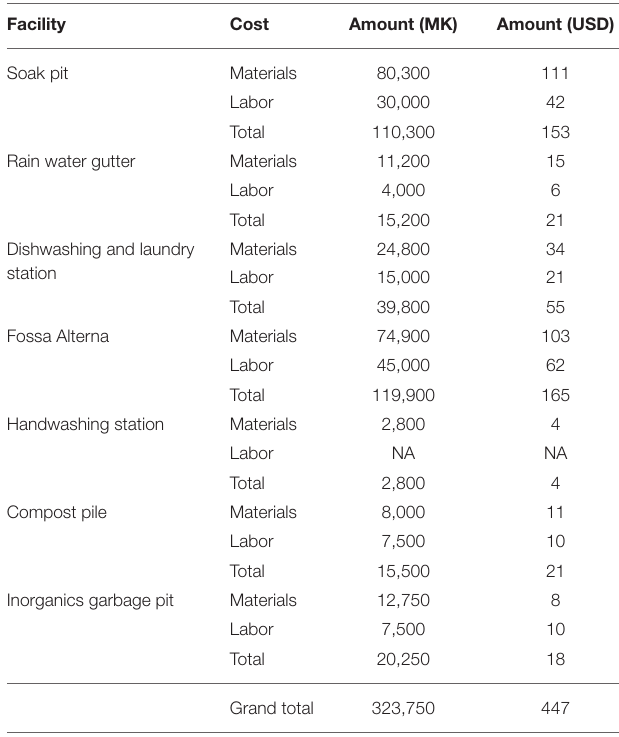
TABLE 2 | Model household expenses (exchange rates were calculated for the month of